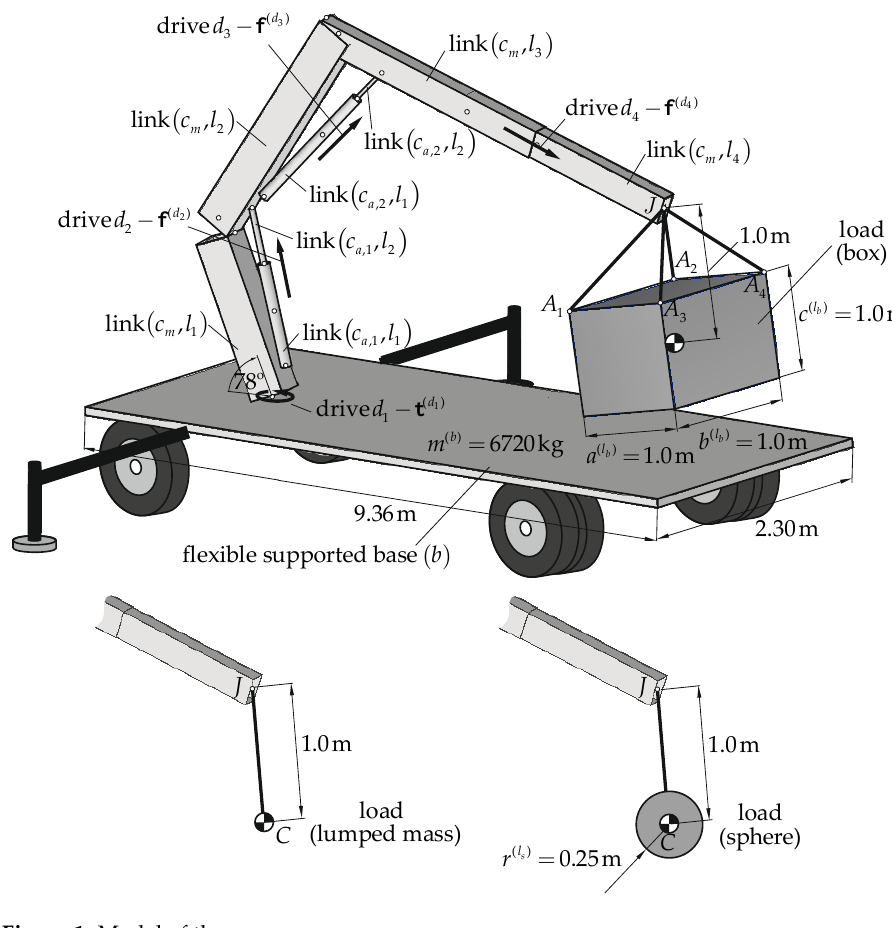
Figure 1. Model of the crane. The selected links of the crane were driven using kinematic input. The assumed values of geometrical parameters are shown in Table